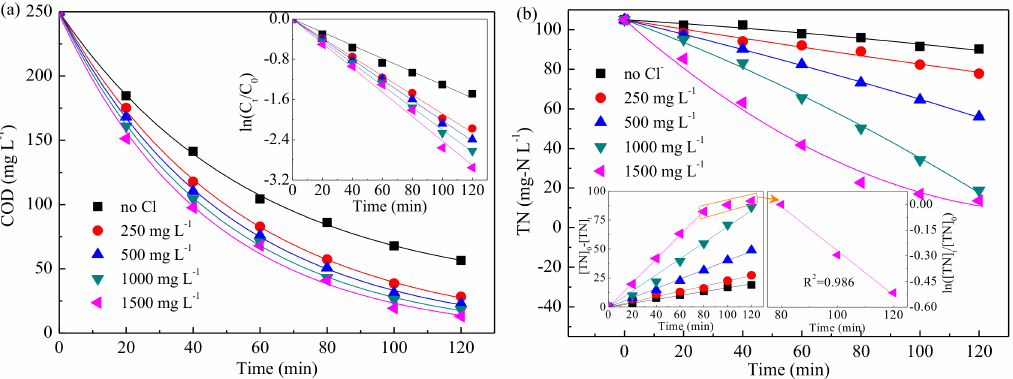
Figure 4. Influence of Cl − concentration on COD ( a ) and TN ( b ) removal. (pH = 6, 10.0 mA · cm − 2